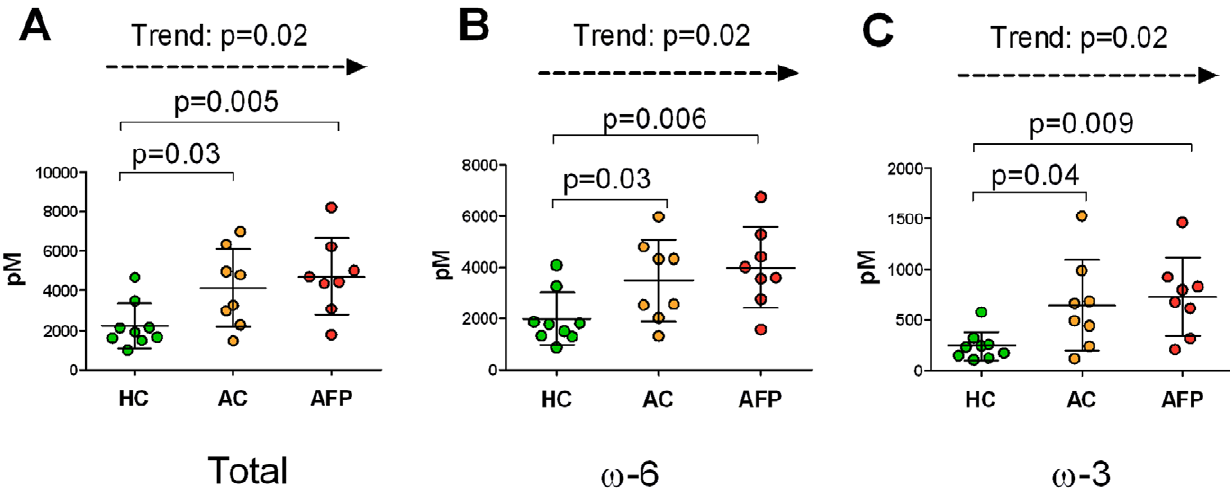
Figure 1. Sum of 15-LOX metabolites. ( A ) Sum of 15-LOX metabolites from both v -3 and v -6 pathways. ( B ) Sum of 15-LOX metabolites from v -6 fatty acids (12-and 15-HETE, 15-KETE, 5,15-DiHETE, 13-HODE, 9,10,13- and 9,12,13-TriHOME, 9-HODE, 9-KODE and 15-HETrE), ( C ) Sum of 15-LOX metabolites from v -3 fatty acids (9- and 13-HOTE, 12- and 15-HEPE and 17-HDoHE). Data are provided as concentration in BALF (pM). HC: Healthy controls, AC: Asthmatic controls, AFP: Asthmatics following provocation. The p-values obtained using Student’s T-test (HC vs. AC and HC vs. AFP) and one-sided Cochran-Armitage trend test (HC, AC and AFP) are indicated in the figure.